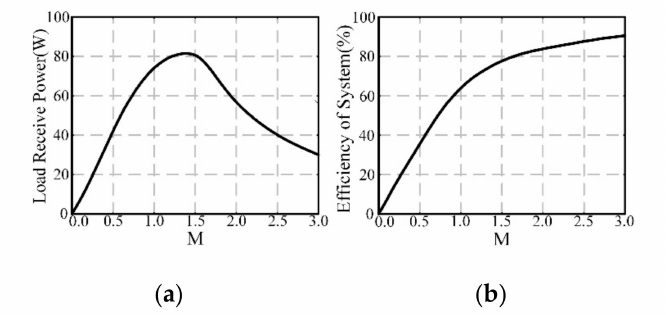
Figure 3. Transmission characteristics vs. mutual inductance. ( a ) Load receive power. ( b ) System efficiency.